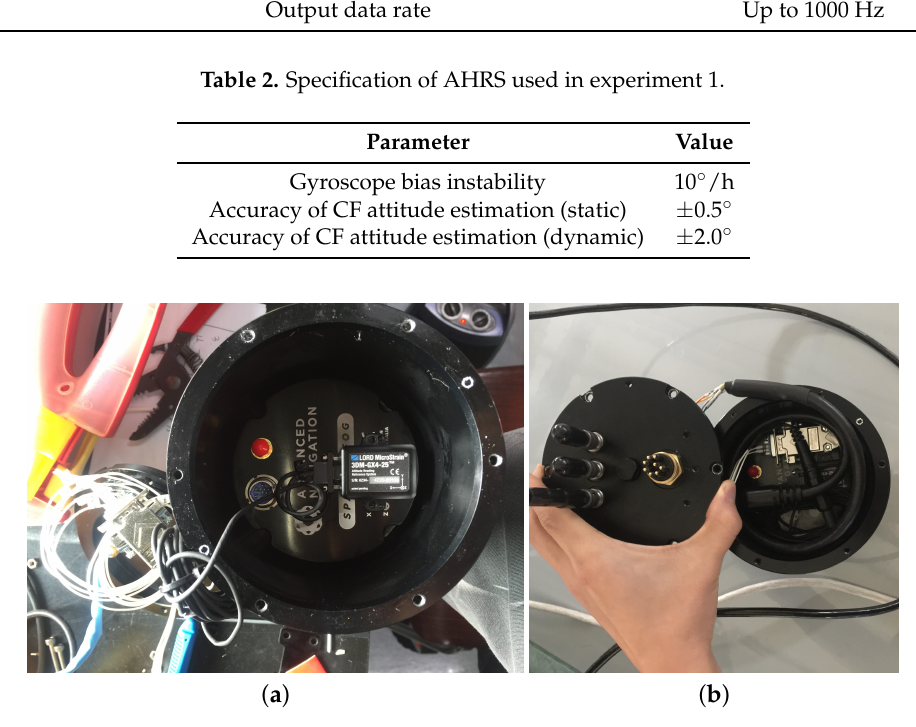
Figure 1. Installation of FOG and AHRS in experiment 1. ( a ) FOG and AHRS in the waterproof hull; ( b ) cover of the waterproof hull.